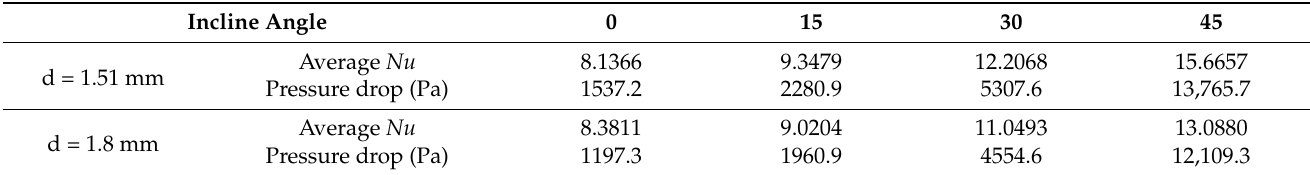
Figure 9. Nu number of hot fluids vs. Re. Table 4. Average Nu and pressure drop of hot fluid.